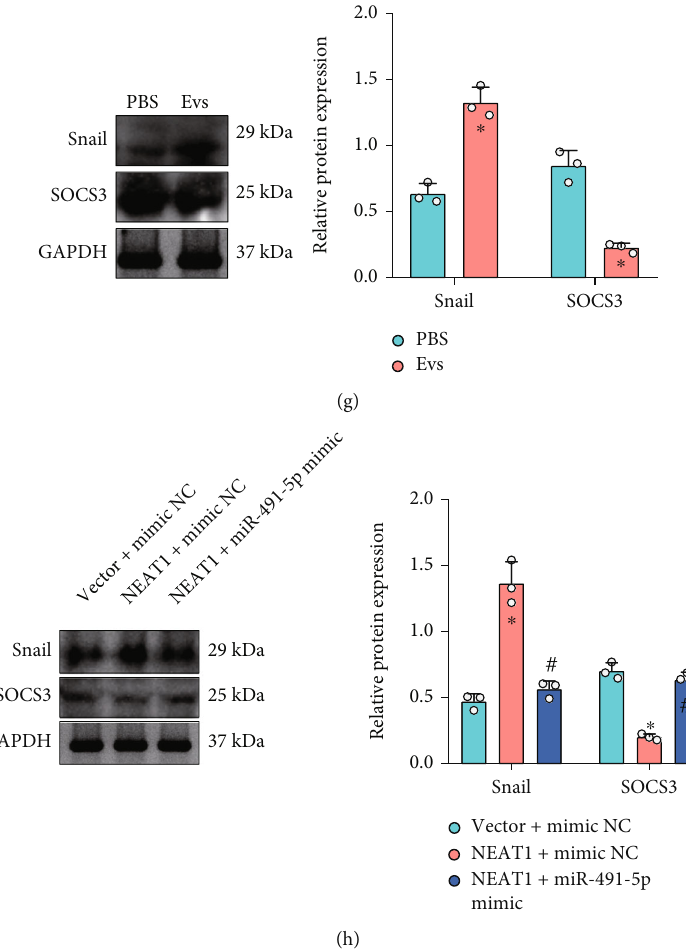
Figure 6: miR-491-5p regulates Snail/SOCS3 in PCa cells. (a) The binding site between miR-491-5p and Snail predicted by StarBase database. (b) The target relationship between miR-491-5p and Snail veri fi ed by dual-luciferase reporter gene assay. (c) Snail expression in SW1990 cells in response to miR-491-5p mimic alone or combined with Snail overexpression determined by Western blot analysis. (d) SOCS3 expression in the PCa-related microarray dataset GSE32676 (normal pancreatic tissues: n = 7 ; PCa tissues: n = 25 ). (e) SOCS3 mRNA level in SW1990 cells in response to miR-491-5p mimic alone or combined with Snail overexpression determined by RT-qPCR. (f) SOCS3 protein level in SW1990 cells determined by Western blot analysis. SW1990 cells were treated with EVs. (g) Protein levels of Snail and SOCS3 in SW1990 cells in response to EVs determined by Western blot analysis. (h) Protein levels of Snail and SOCS3 in SW1990 cells in response to overexpression of NEAT1 alone or combined with miR-491-5p determined by Western blot analysis. ∗ p < 0 : 05 vs. SW1990 cells transduced with mimic NC, inhibitor NC, PBS, or Vector+NC mimic. # p < 0 : 05 vs. SW1990 cells transduced with miR-491-5p mimic+Vector or NEAT1+NC mimic. All data were presented as mean ± standard deviation. Comparisons of data between two groups were analyzed by unpaired t -test, and comparison of data among multiple groups was tested by one-way analysis of variance, followed by Tukey ’ s post hoc test. Cell experiments were independently repeated three